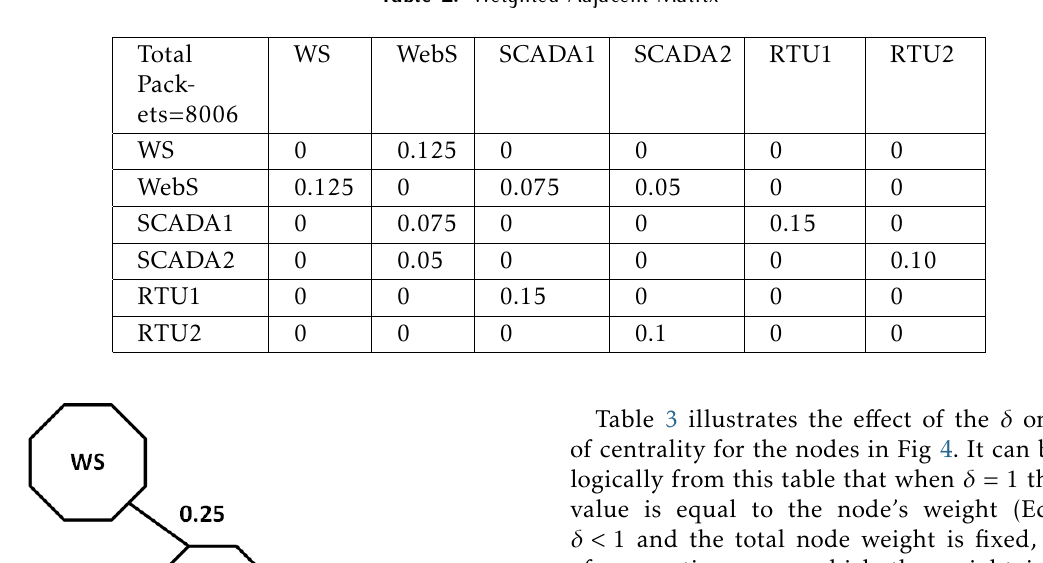
Table 2. Weighted Adjacent Matrix